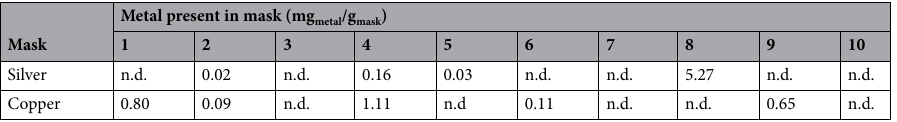
Table 2. Total silver and/or copper present in as received masks; n.d. denotes samples where metal was not detected. Standard deviation for every value is less than 0.01 mg metal/g mask.